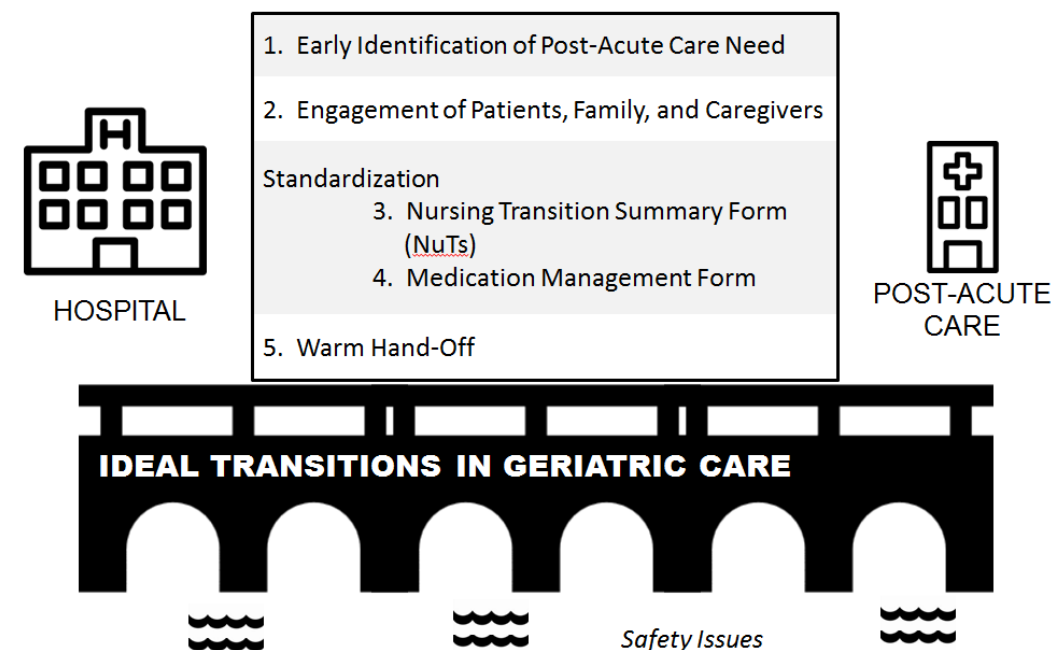
Figure 1. Essential elements of the IMPACT (IMproving Post Acute Care Transitions) program to ensure ideal transitions in geriatric care. Adapted from Burke et al. [38]. * Both the NuTS and the Medication Management Forms are reproduced in full in Appendix A.